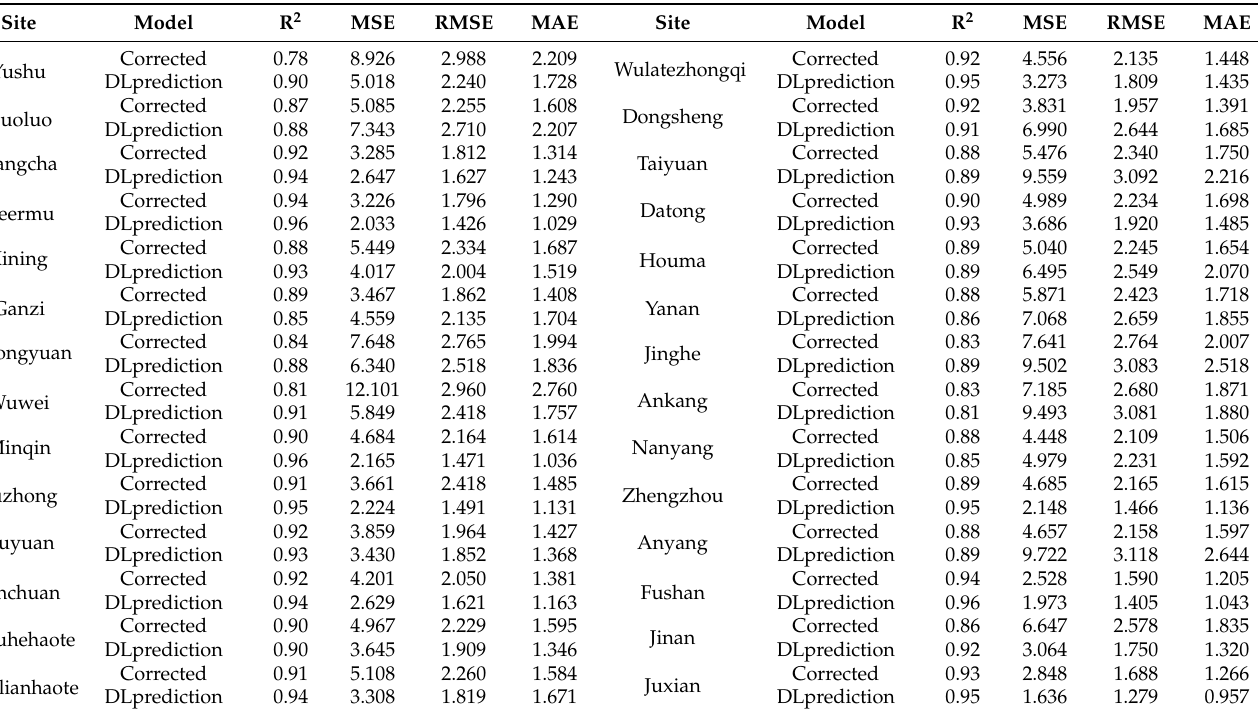
Table 4. Performance comparison between the prediction results of the corrected values of the Å-P parameters and the prediction results of the DL